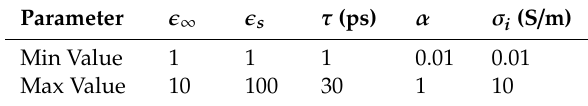
Table 2. Intervals chosen for the Cole–Cole parameters to define the solution